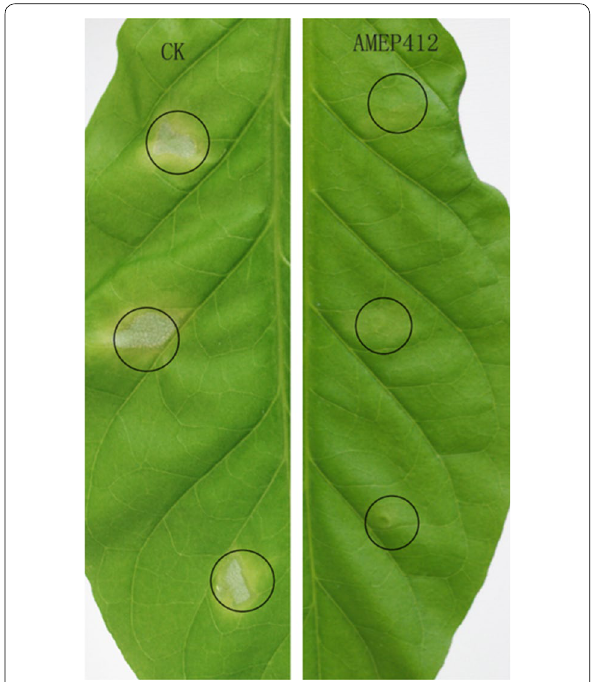
Fig. 7 AMEP412 induced systemic resistance in tobacco against Pst